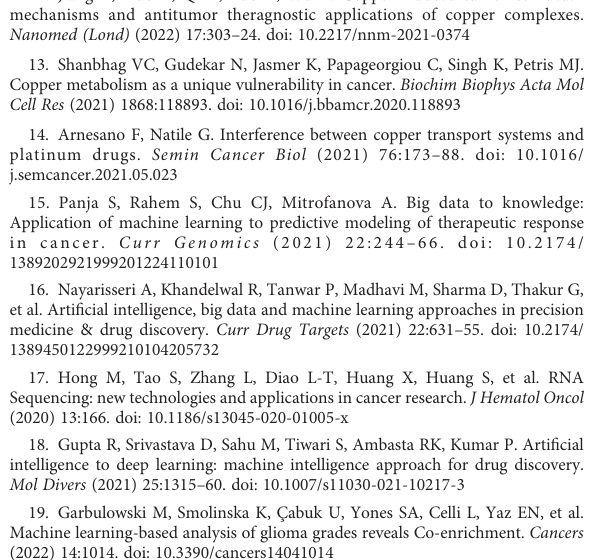
SUPPLEMENTARY TABLE 1 Names of 13 cuproptosis-related genes